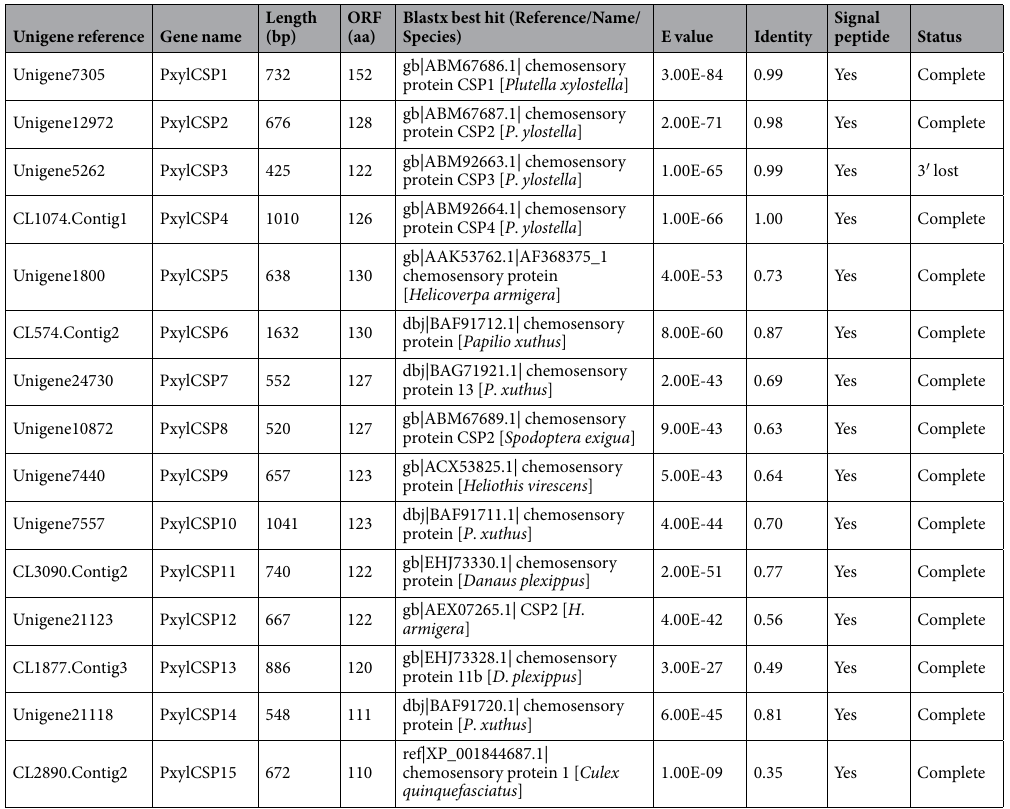
Table 5. Candidate chemosensory protein